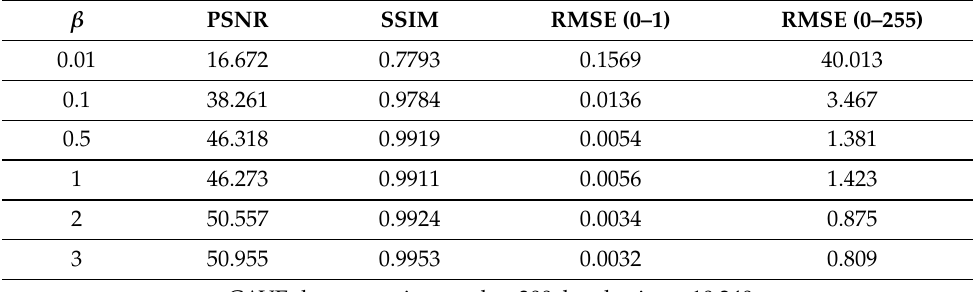
Table 11. The MSI to RGB RMSE changes against the β